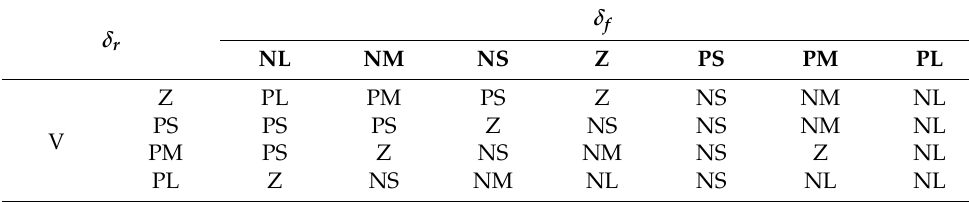
Figure 10. Membership function of input variable E1, EC1 and output variable U1. Table 5. Fuzzy rules of front wheel steering angle and speed of the fuzzy feedforward